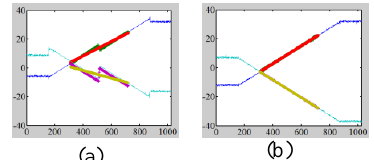
Figure 3. Comparison of SVD and AD-SVD unwrapping and LSF fitting results. (a) SVD results of the PC matrix for Fig. 1(a)-(b). (b) AD-SVD results of Fig. 1(a)-(b).